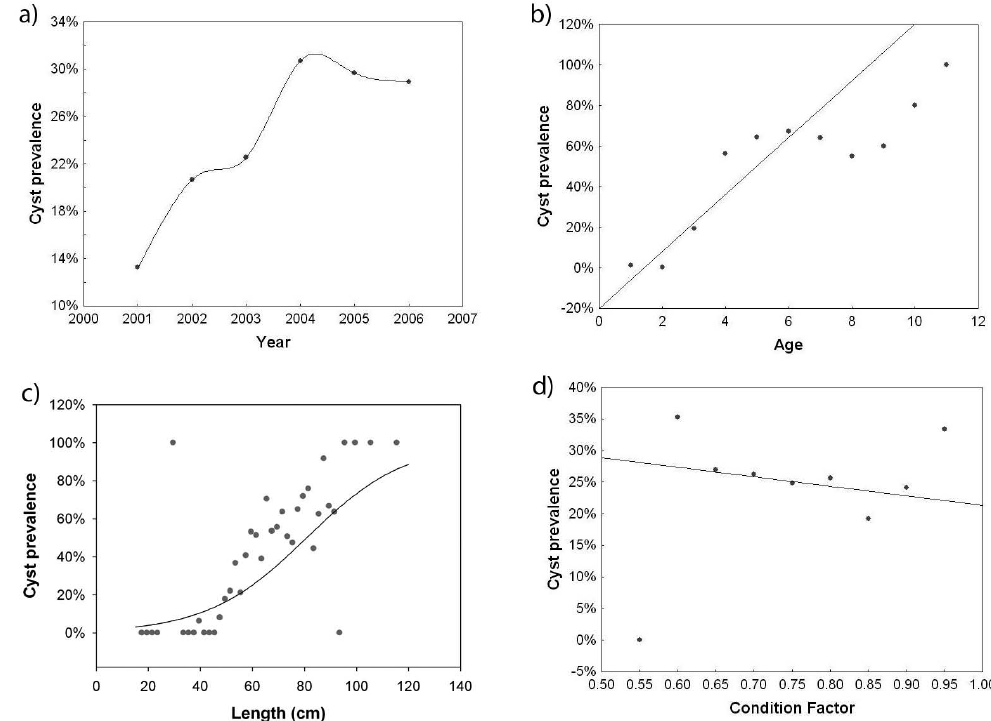
Fig. 5 . – For Atlantic cod: a) annual mean of cyst prevalence; b) mean of cyst prevalence by female age (y=0-0.1998+0.1403x); c) logistic relationship between cyst prevalence and female length ( y = e (–4.247+0.052 x ) /1+ e (–4.247+0.052 x ) ); and d) linear relationship between cyst prevalence and female condition factor